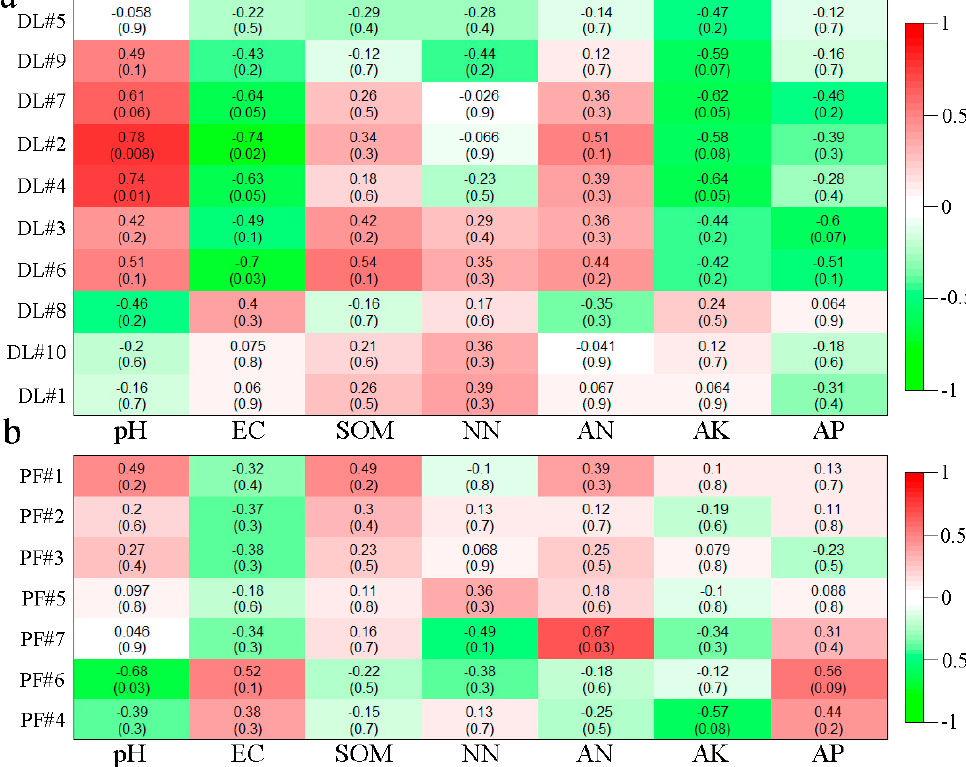
Figure 8. Heatmap analysis of fungal module correlation with environmental factors in DL ( a ) and PF ( b ).